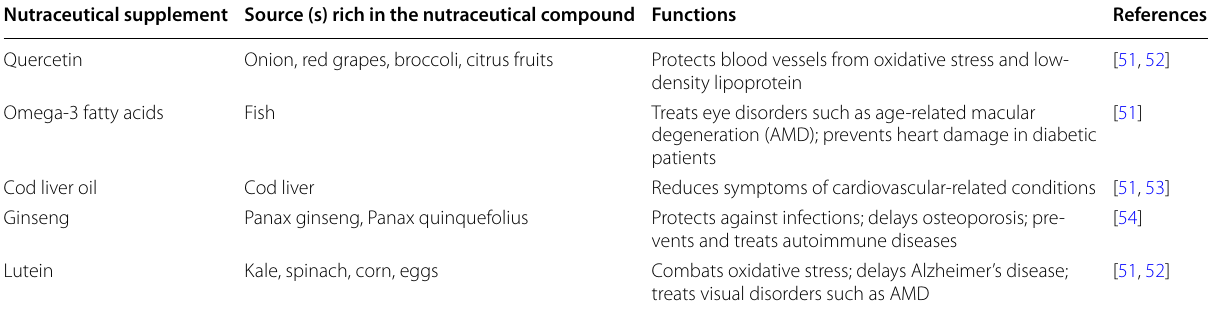
Table 3 Selected nutraceutical supplements with their associated benefits summarized Nutraceutical supplement Source (s) rich in the nutraceutical compound